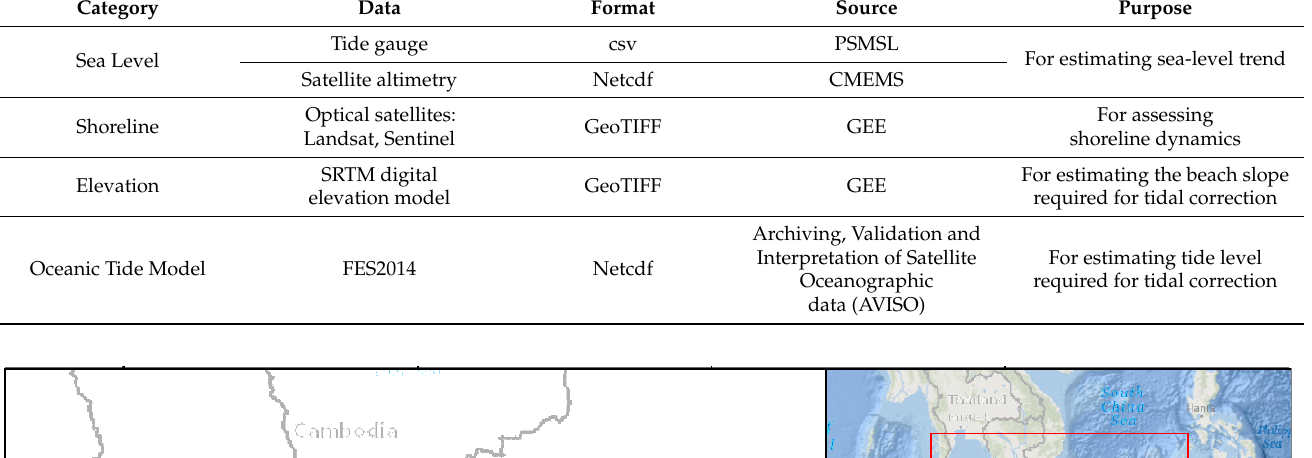
Table 1. Formats, sources, and purposes of the data employed in this study.